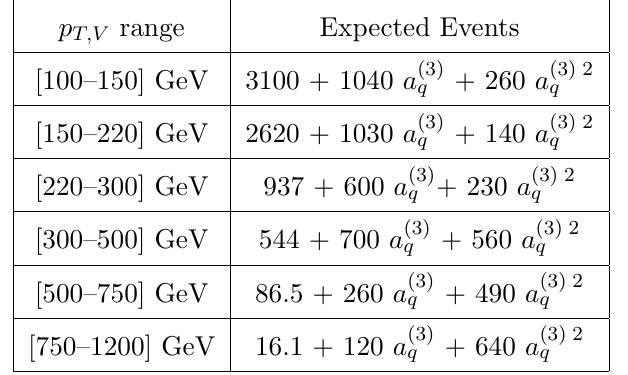
Figure 5 . Rescaled accuracy as a function of the cut on the scattering angle j cos (cid:18) of the transverse momentum of the WZ system p T;V V (right panel). The solid, dashed, dot-dashed and dotted lines correspond to the three p T;V bins described in the main text. The black lines are obtained by imposing the additional cuts p T;V V (cid:20) p T;V = 2 in the left plot and j cos (cid:18) (cid:3) j < 0 : 5 in the right plot. The orange lines are obtained with no additional cut.